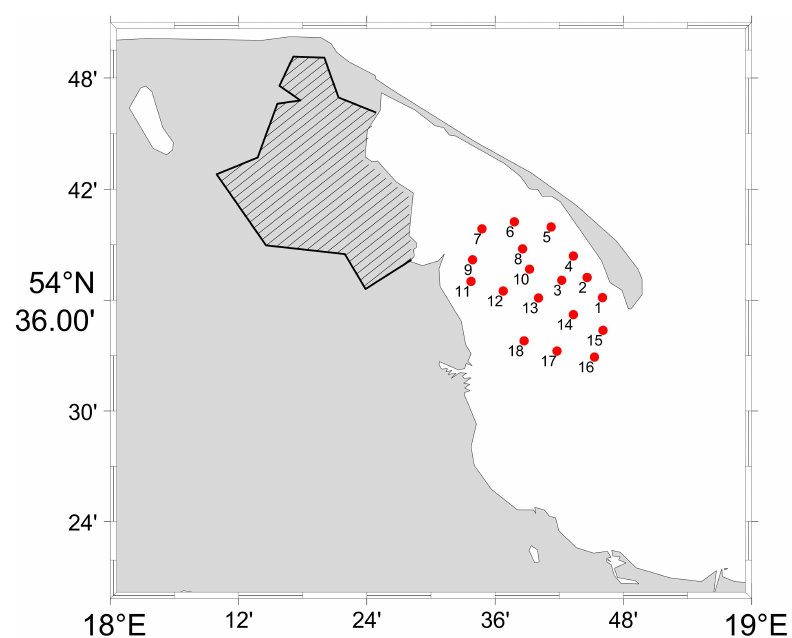
Figure 2. Location of stations for vertical profiles collected from s/y